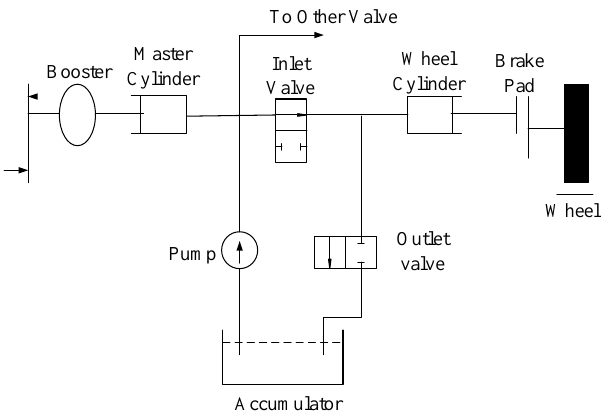
Figure 4. Anti-lock braking system (ABS) hydraulic brake